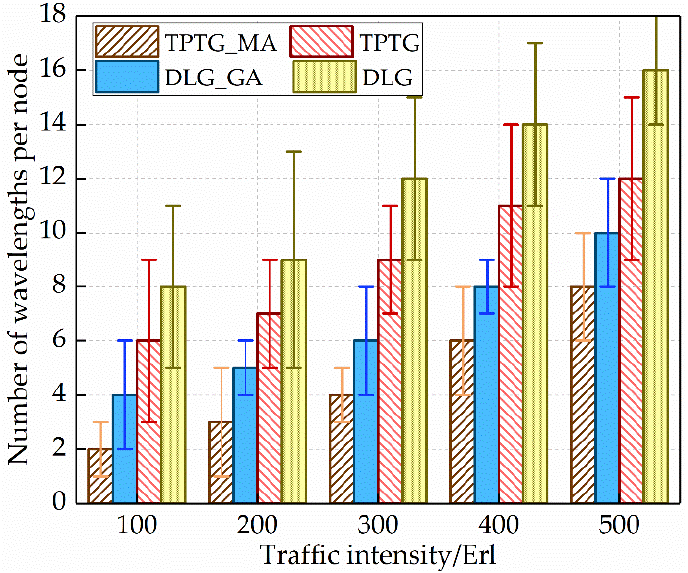
Figure 5. Comparison of the number of wavelengths per node between the DLG, TPTG, DLG_GA, and TPTG_MA.